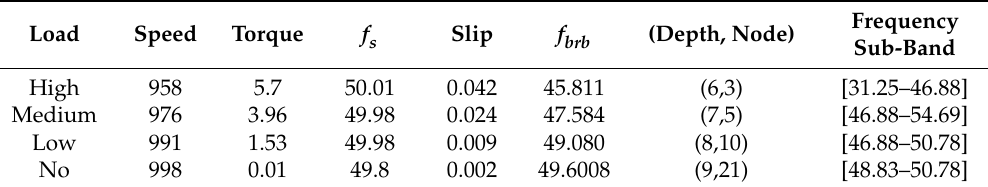
Table 2. Sub-Band Frequency Selection Based on